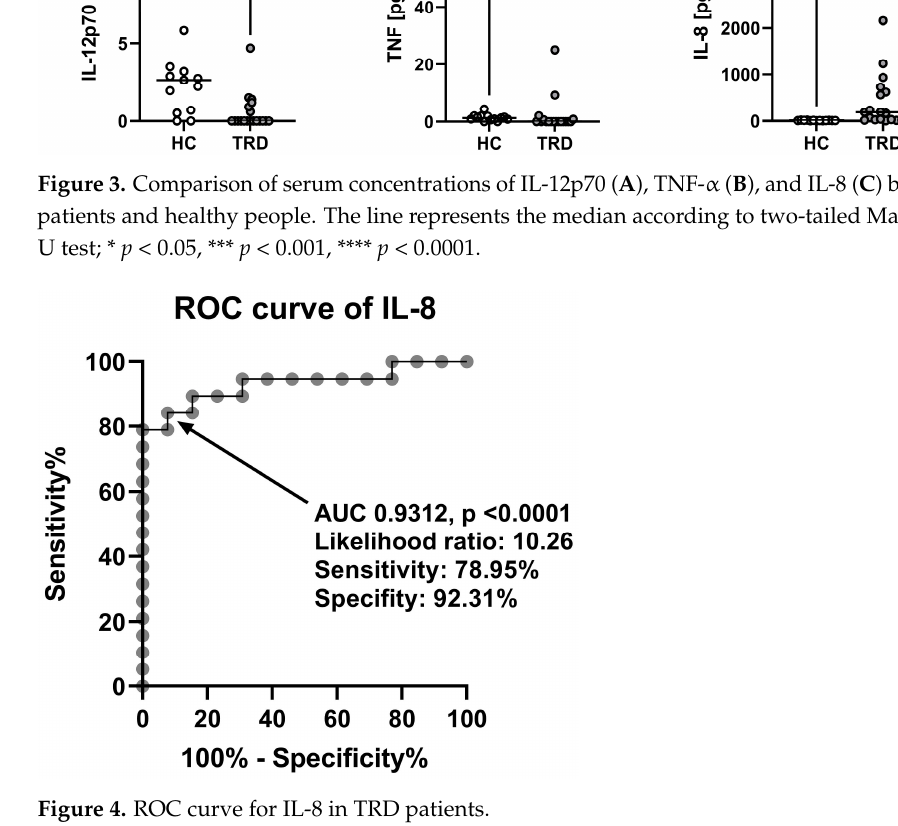
Figure 4. ROC curve for IL-8 in TRD patients.